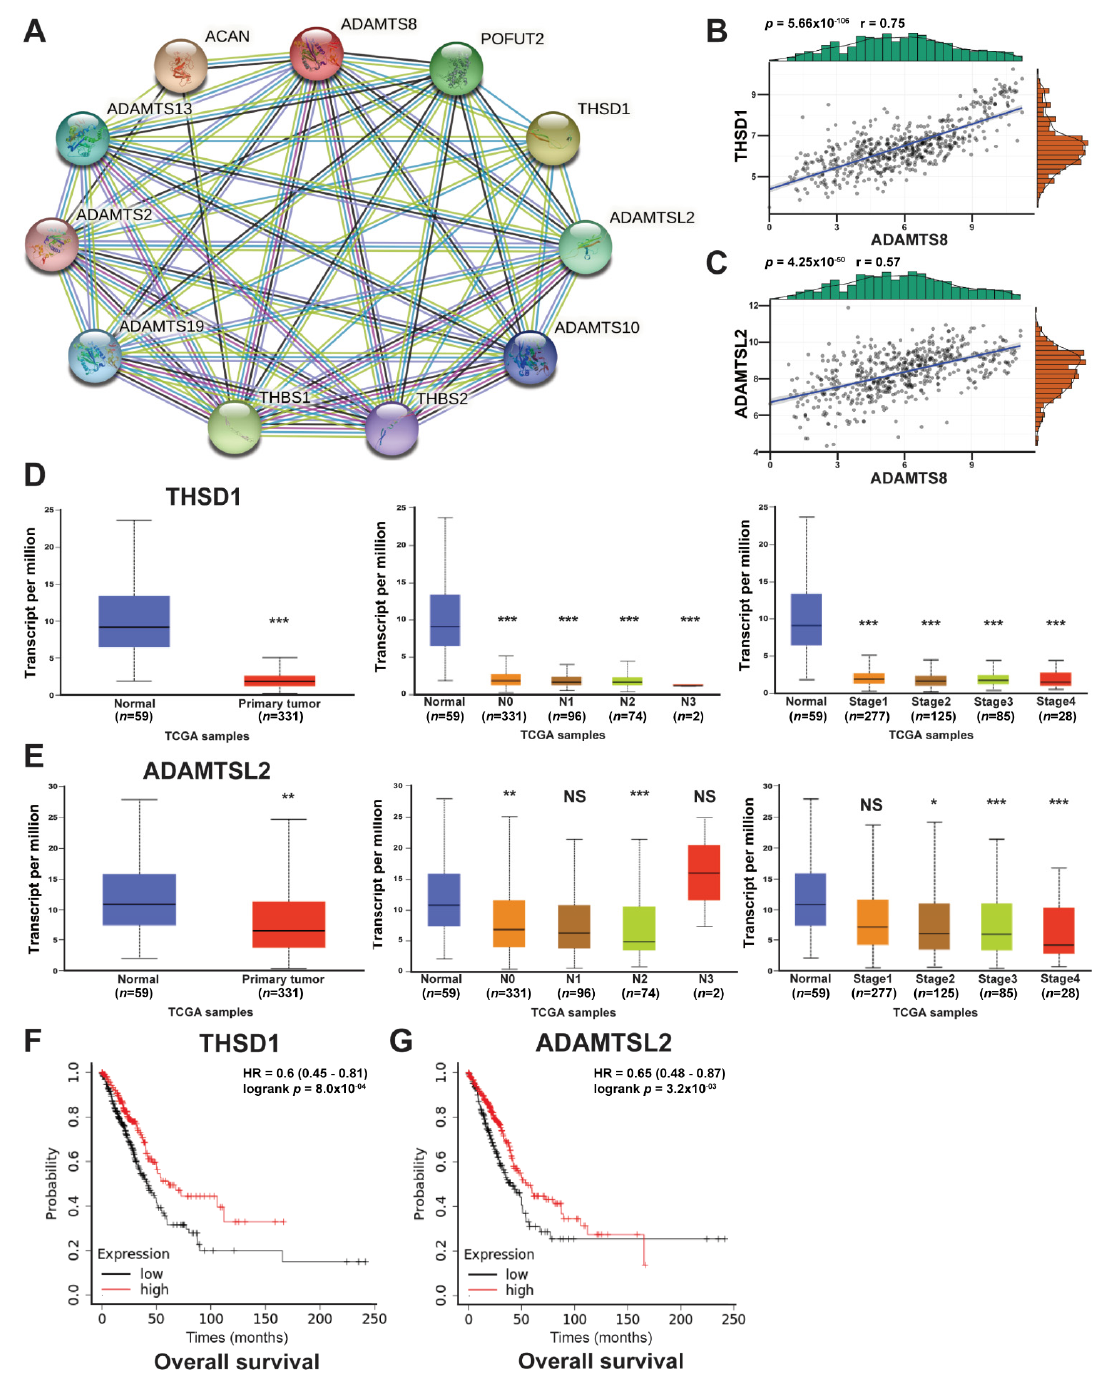
Figure 6. The network interaction between ADAMTSL2, THSD1 and ADAMTS8. The protein–protein interactions of ADAMTS8 utilizing STRING (protein, version 11.0b) revealed the interactions ( A ). The r values for the correlation between ADAMTS8 and ADAMTSL2 and THDS1 were 0.58 and 0.75, respectively, for the TCGA cohort ( B , C ). The expression of ADAMTSL2 in the tumor parts was lower than in the normal parts (left panel, D ); we also show its relation with lymph node metastasis or tumor stage (middle and right panels, D ). The expression of THSD1 in tumor parts was lower than in normal parts (left panel, E ); we also show its relation with lymph node metastasis or tumor stage (middle and right panel, E ). The effects of THSD1 ( F ) and ADAMTSL2 ( G ) on overall survival analysis. * p < 0.05, ** p < 0.01, *** p <